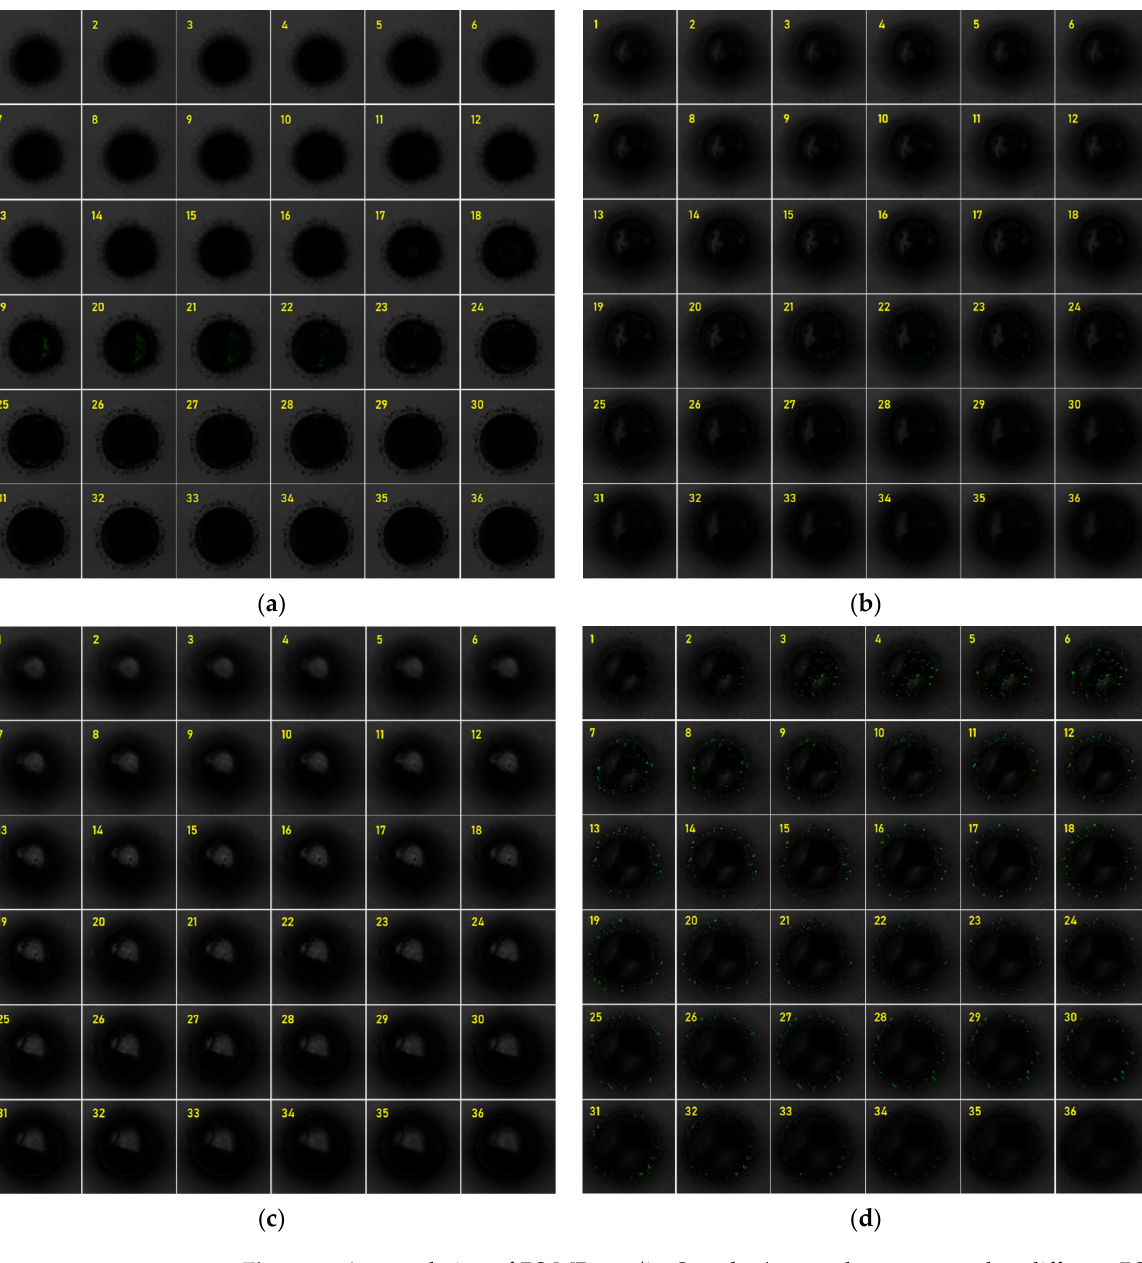
Figure 1. Accumulation of PS-MPs on/in O. melastigma embryos exposed to different PS-MPs of different sizes (n = 9): ( a ) control group; ( b ) 0.05 μ m; ( c ) 0.5 μ m; ( d ) 6.0 μ m. Fluorescent images were captured continuously from the top to the bottom of the embryo in the z -axis every 20 nm. The numbers (1–36) show the cross-section image from the upper part to the lower part of an embryo.